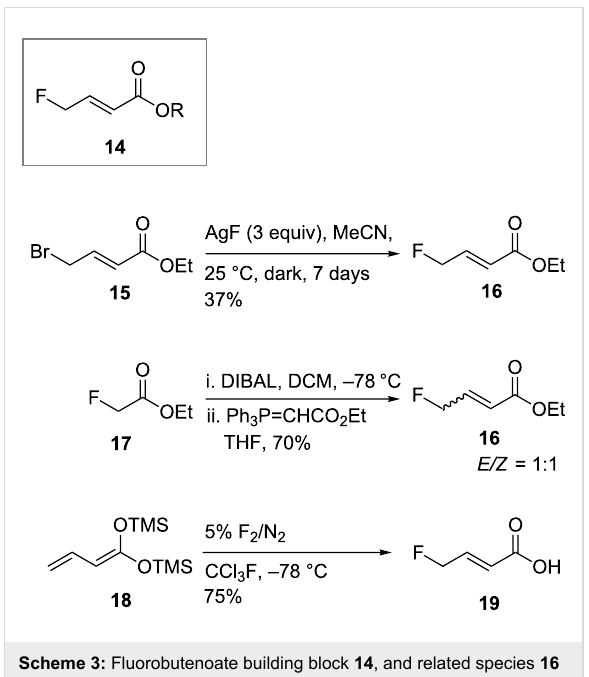
Figure 1: Side product 27 isolated from attempted